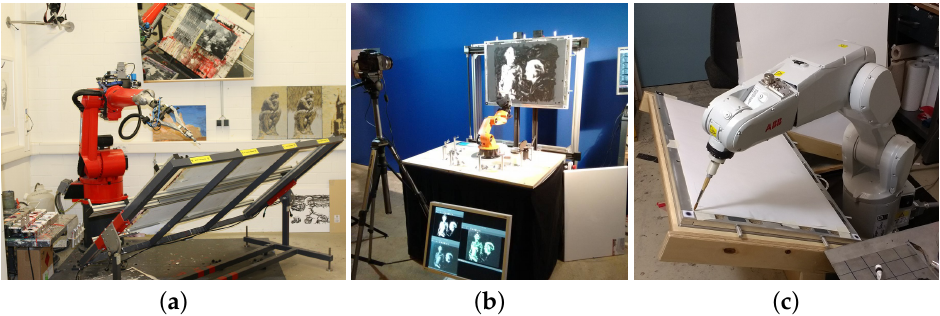
Figure 4. The robots used for the e-David project. ( a ) Reis RV-20 6: The main robot (active); ( b ) KUKA YouBot: Mobile demonstrator (retired); ( c ) ABB IRB 1200: Mobile demonstrator